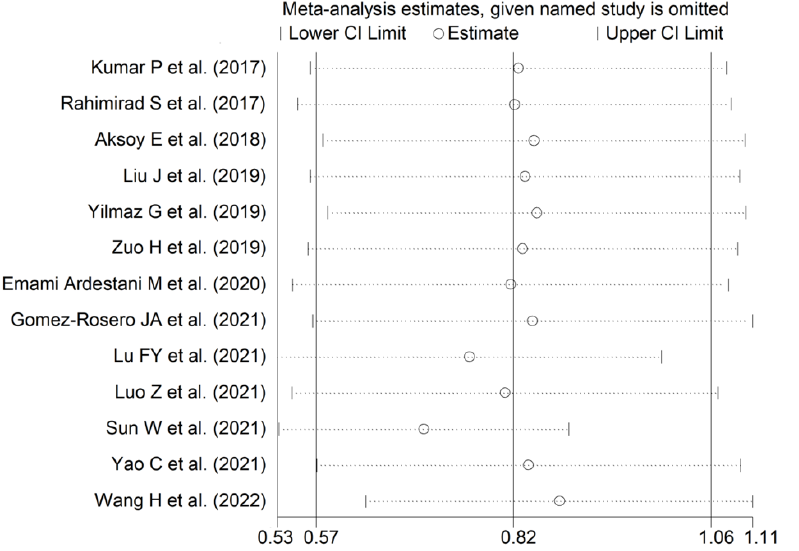
Figure 9. Sensitivity analysis of the association between the neutrophil-to-lymphocyte ratio and adverse outcomes, showing the influence of individual studies on the overall SMD. The middle vertical axis indicates the overall SMD, and the two vertical axes indicate the 95% confidence intervals. The hollow circles represent the pooled SMD of the remaining studies when an individual study is omitted from the meta-analysis. The two ends of each broken line represent the 95% confidence intervals.